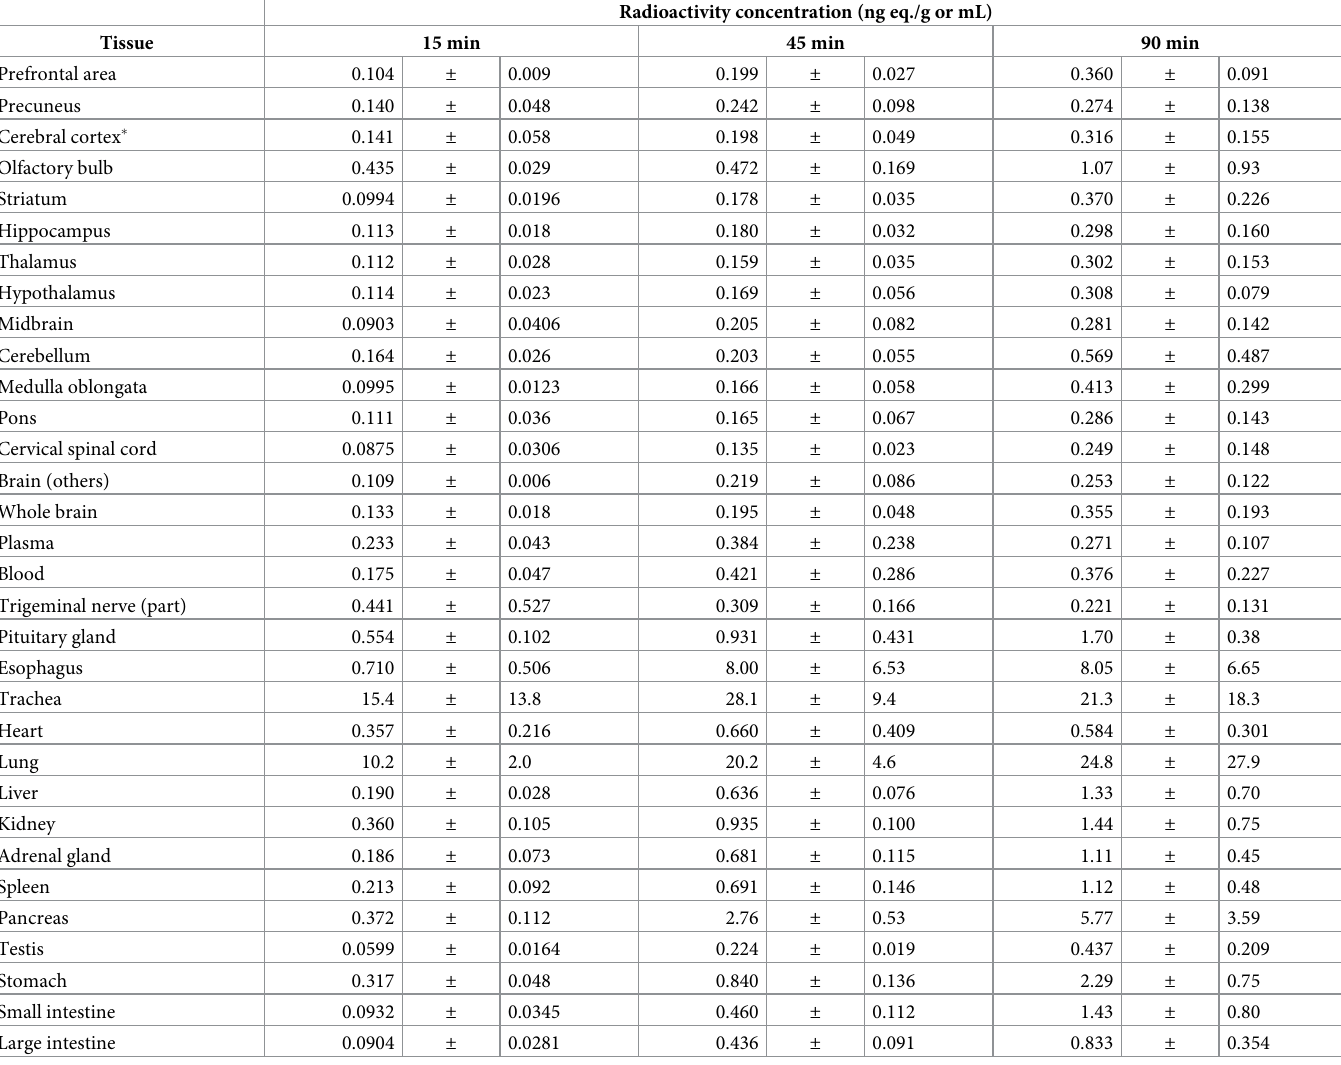
Table 2. Radioactivity concentrations in tissues after single intranasal administration of [ 3 H]control formulation to male rabbits (dose: 4